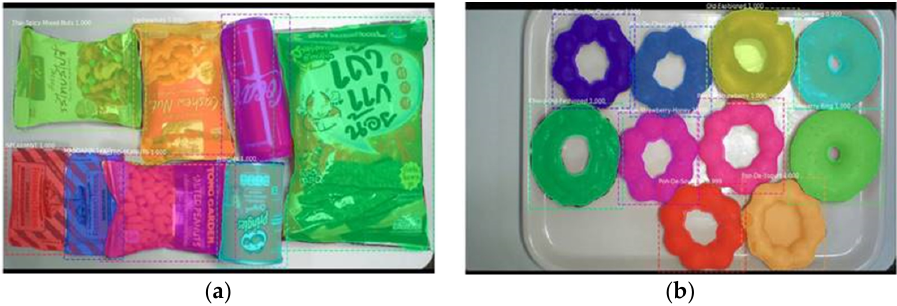
Figure 11. Experimental results: ( a ) snacks and ( b ) donuts.